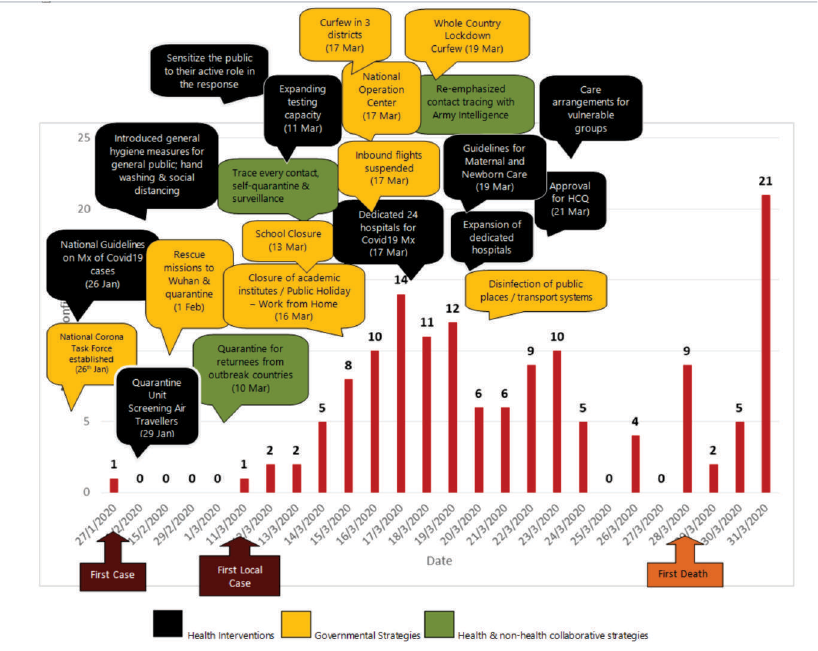
Figure 2: Cumulative number of cases and key